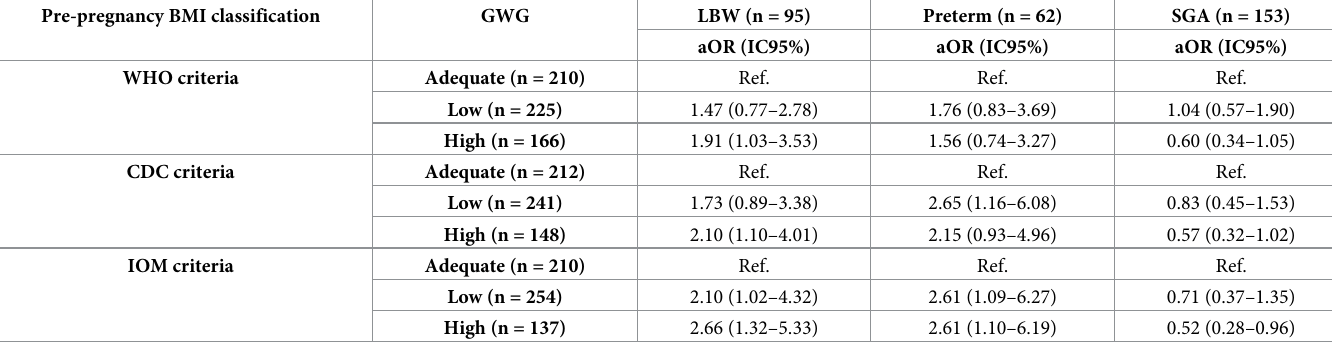
Table 5. Associations between neonatal outcomes and gestational weight gain using pre-pregnancy BMI. Pre-pregnancy BMI